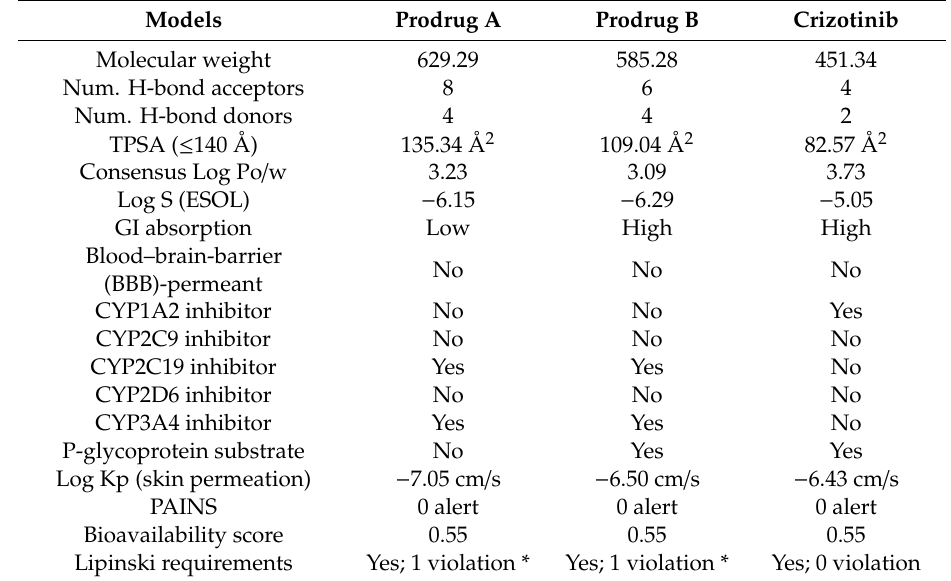
Table 1. In silico adsorption, distribution, metabolization, excretion (ADME) calculations to predict the “drug-likeness” of prodrug A , prodrug B and crizotinib using